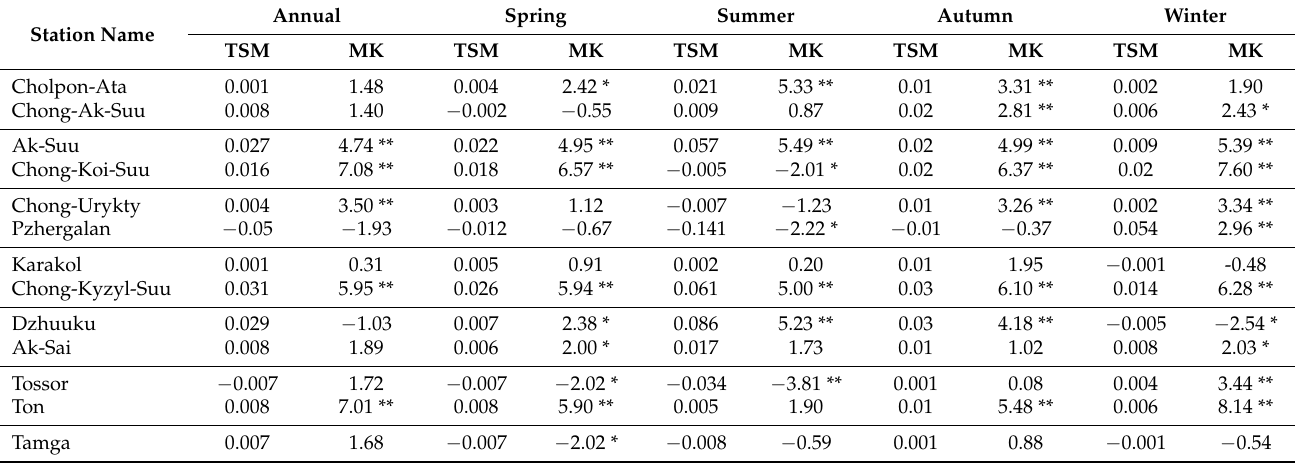
Table 2. Analysis of MK trend test and TSM trend analysis for the temporal runoff dynamics (1943–2012).